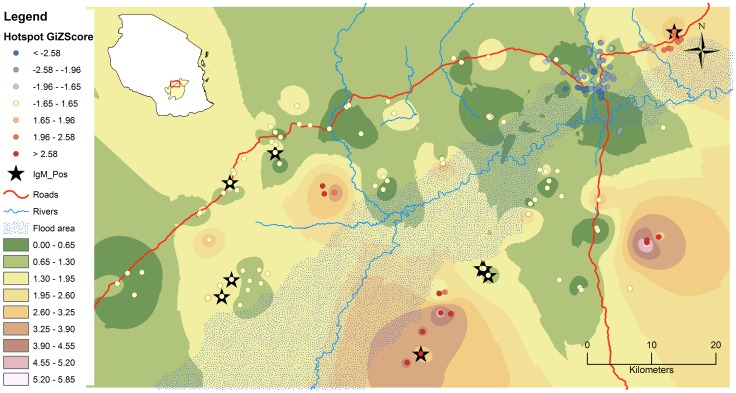
Study area depicting spatial distribution pattern of RVF seroconversion in livestock.The graduated colors indicate output of IDW based on actual number of seropositive animals to RVFV antibodies in all species. The round dots represent location of households from which livestock were sampled and clustering pattern given by Z-scores (red, blue and white colorations indicating hotspot, cold spot and random pattern respectively). The black stars indicate households where IgM positive animals were sampled. The insert is Map of Tanzania showing districts of Kilombero and Ulanga, and location of study site within.